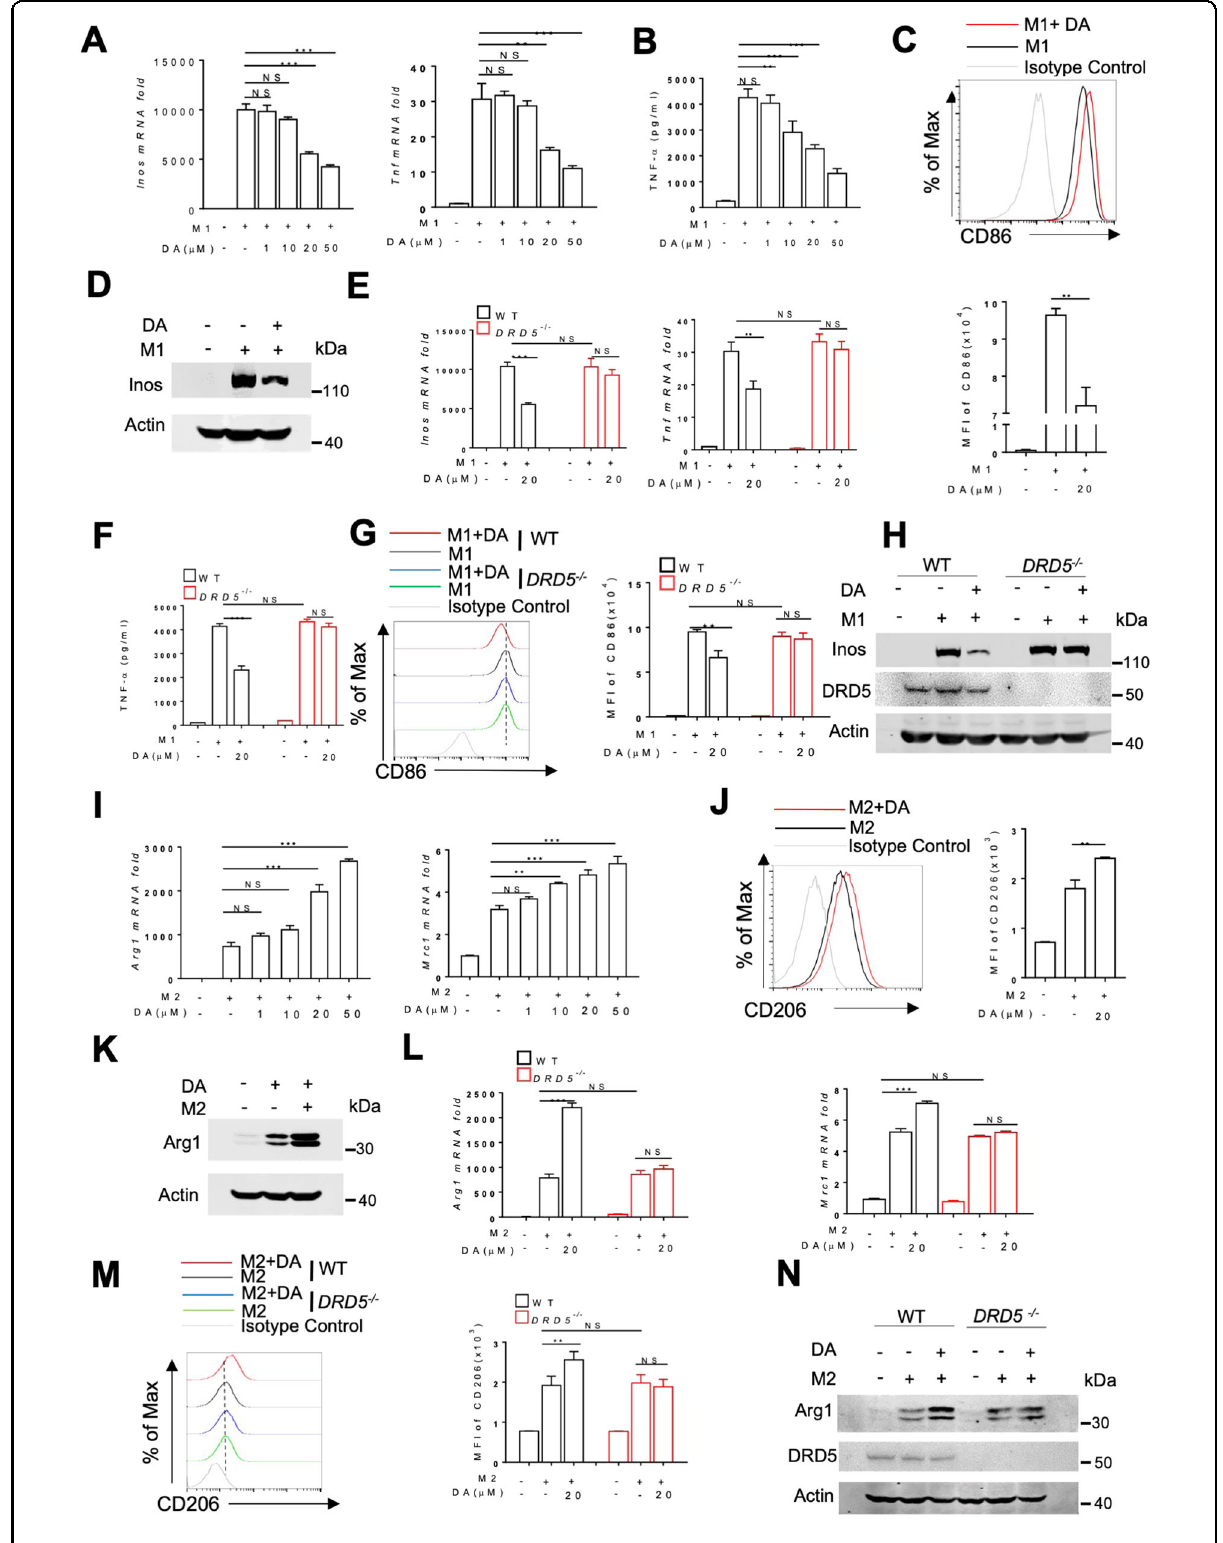
Fig. 3 (See legend on next